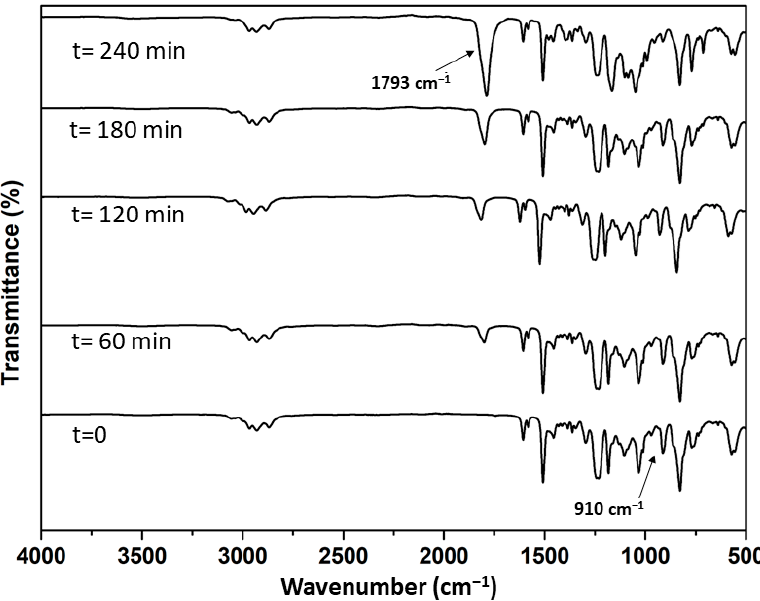
Figure 1. ATR-FTIR spectra of different time for the synthesis of cyclic carbonate from commercial epoxy.